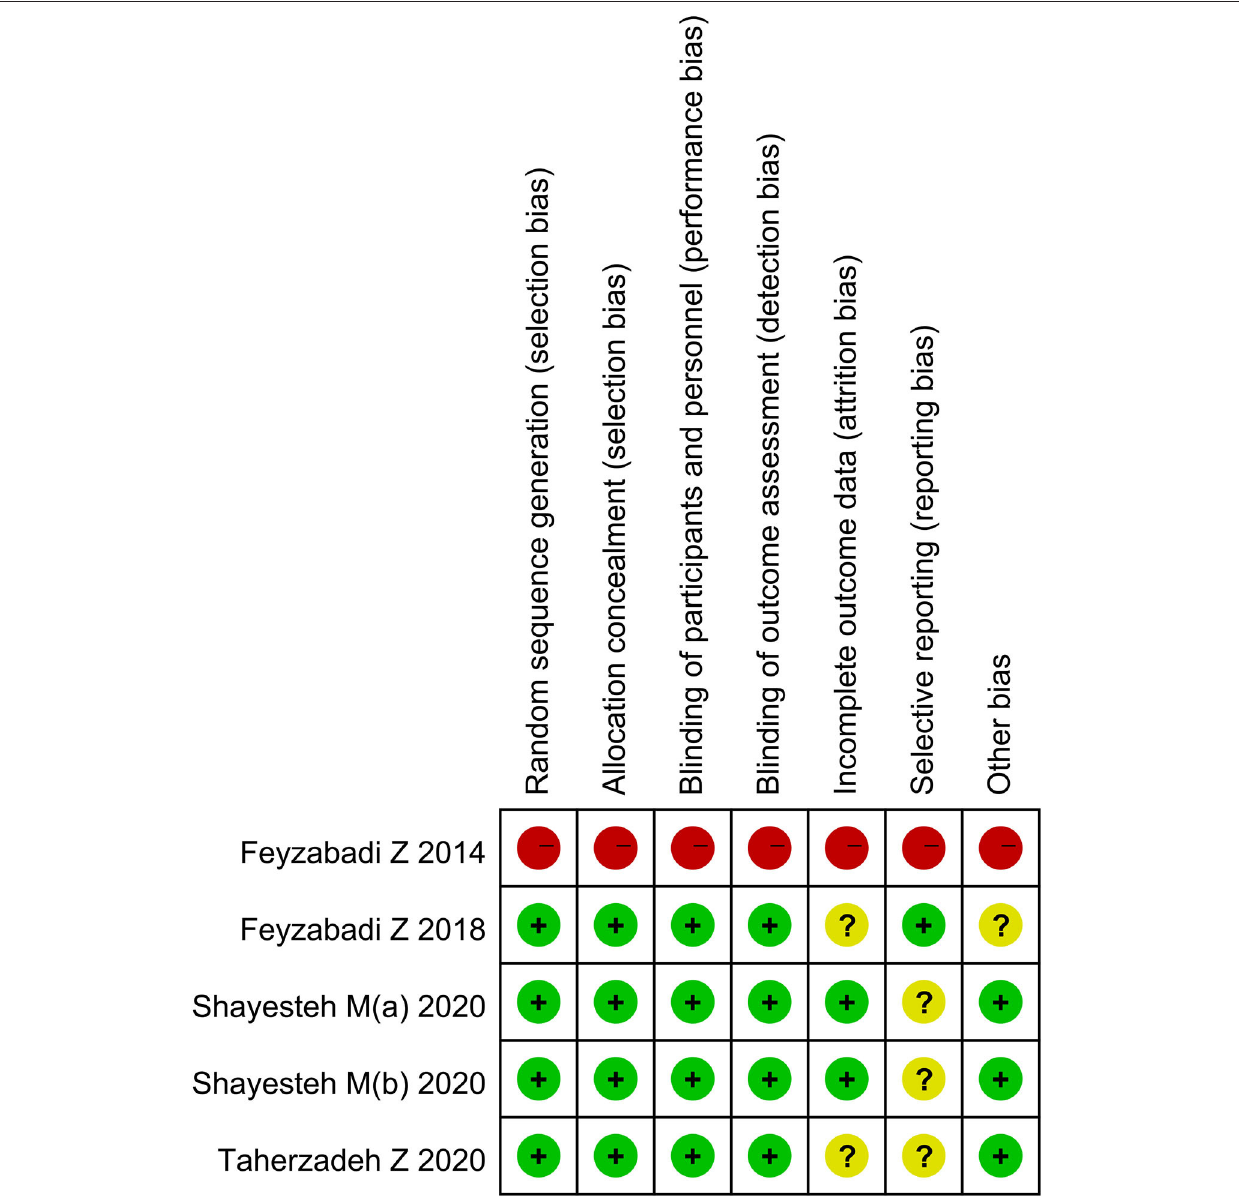
FIGURE 2 | The risk of bias